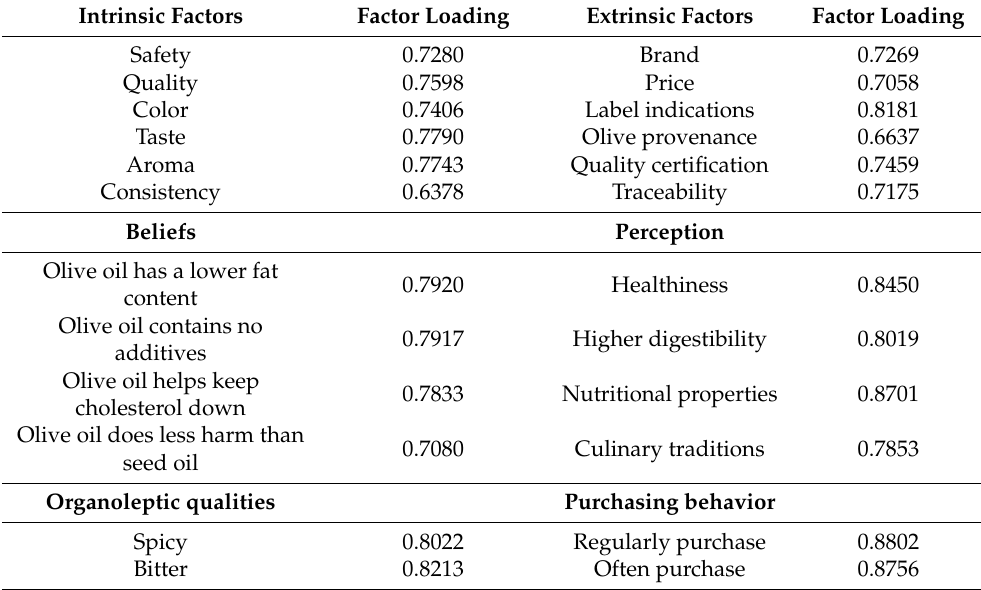
Table 2. Results from the exploratory factor analysis (EFA)